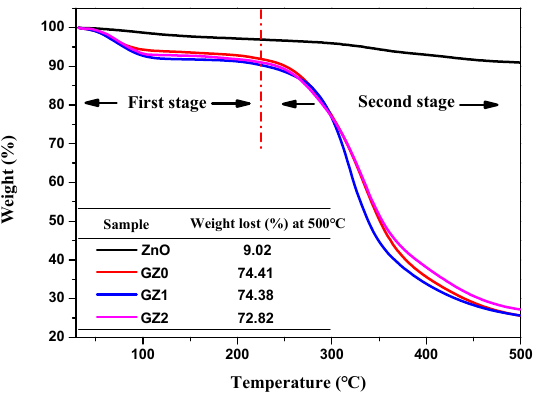
Figure 7. Thermogravimetric analysis (TGA) curve of ZnO, GZ0, GZ1 and GZ2.